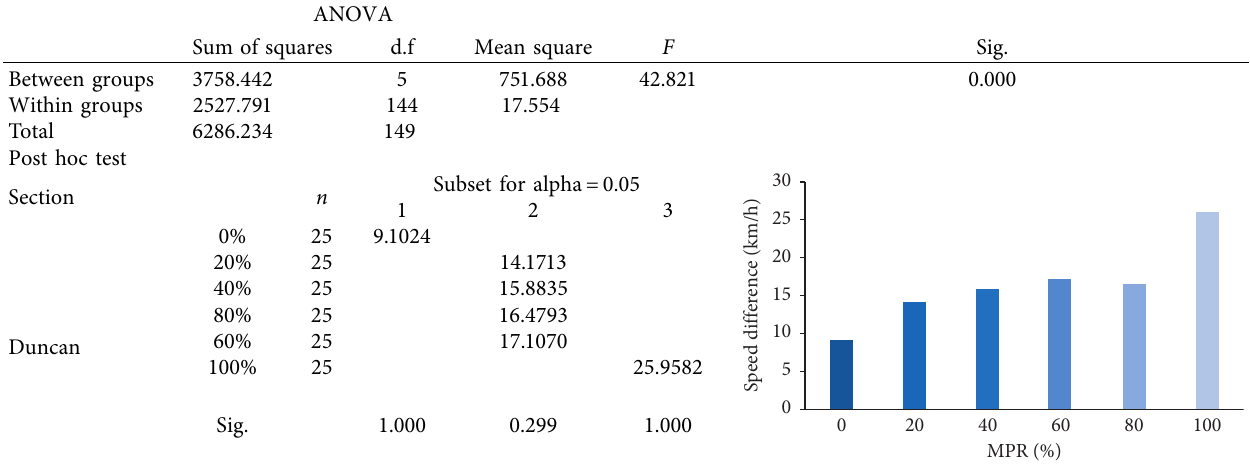
Table 5: Analysis results of speed difference between lanes by